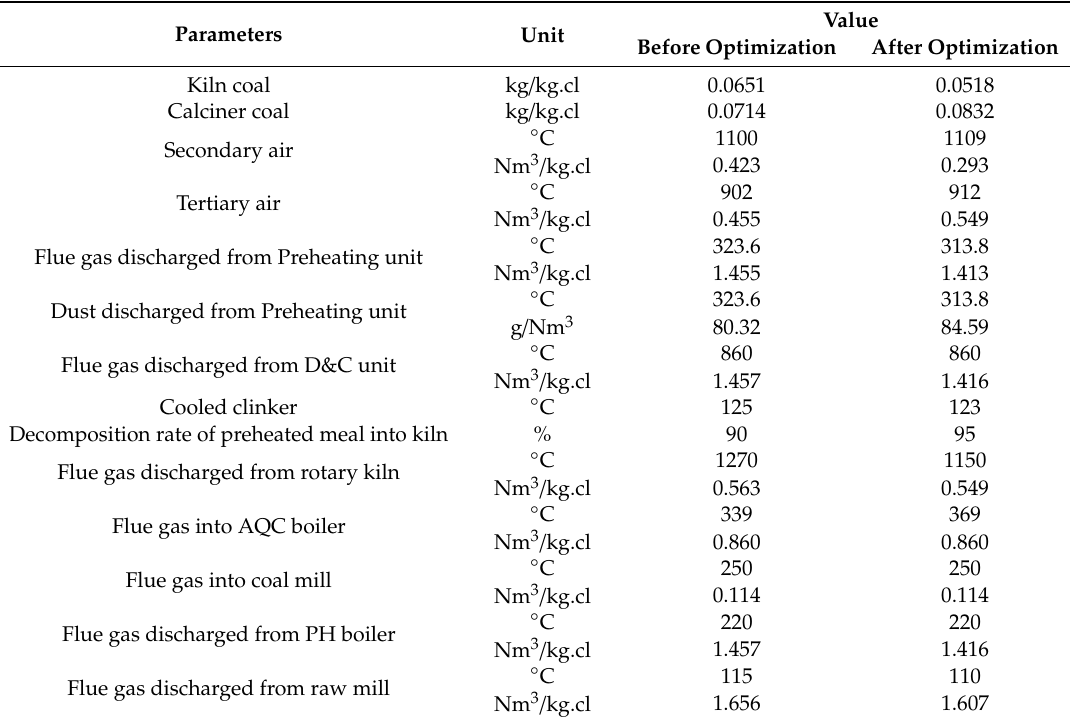
Table 4. Main parameters of the production line.